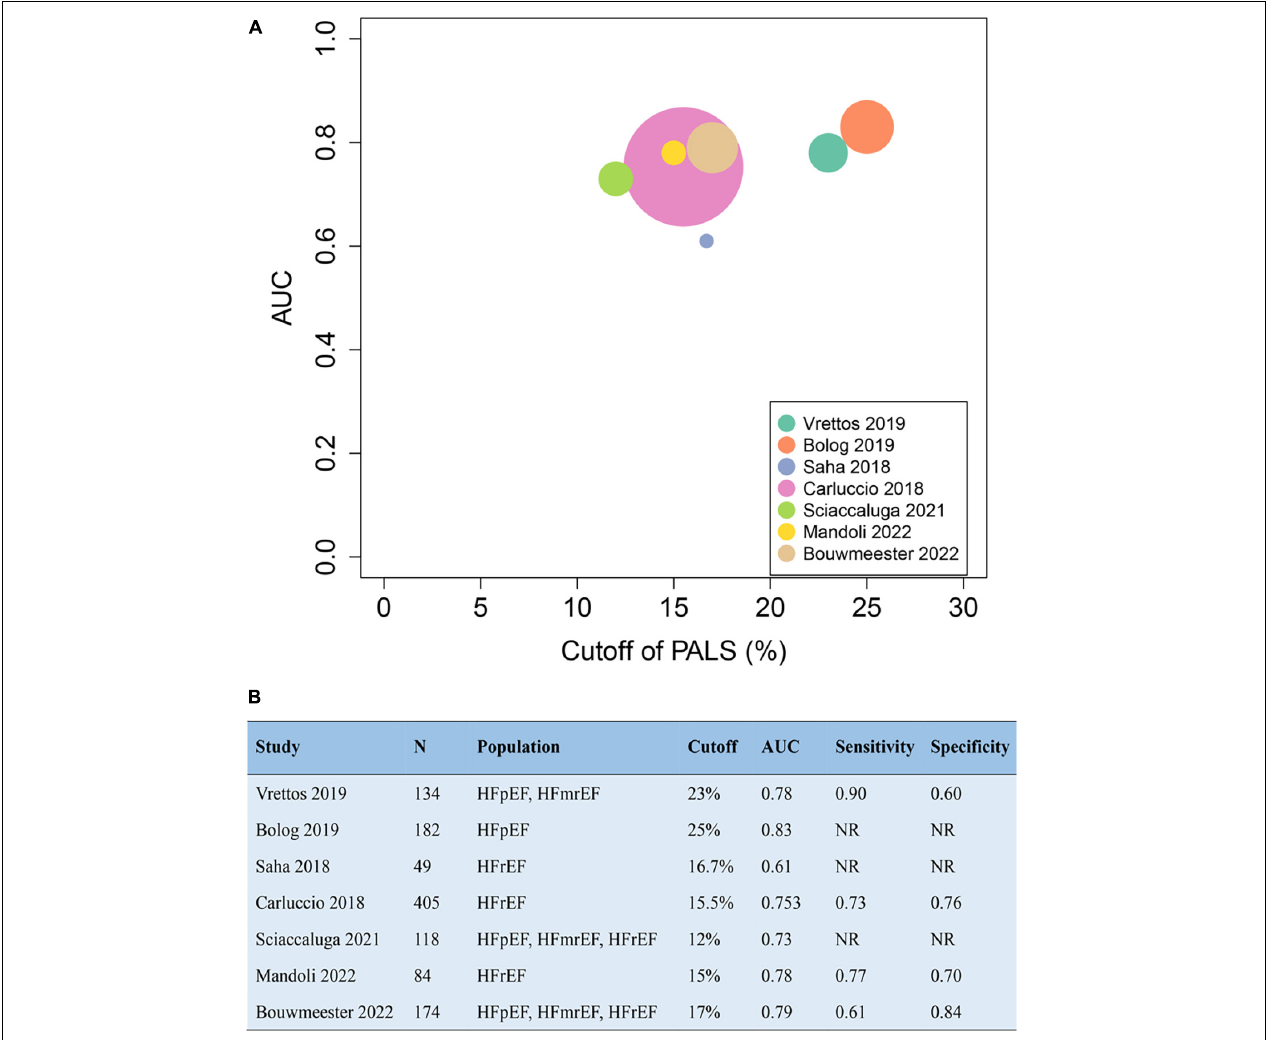
FIGURE 5 | The cutoff value and AUC of peak atrial longitudinal strain (PALS) in receiver operating characteristics curve to identify risk stratification for endpoint (A) according to the seven studies (B) . AUC, area under the